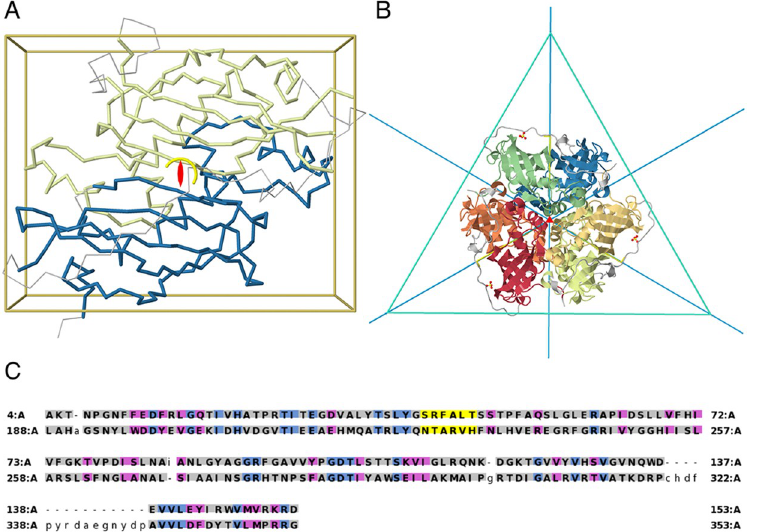
Fig 4. Hot dog fold duplication. A) Internal C2 symmetry in one chain of a MaoC domain protein dehydratase from Chloroflexus aurantiacus (4E3E) displaying a “double hot dog” fold. B) Full trimeric assembly, with the six individual hot dog domains colored. The quaternary structure has a threefold cyclic symmetry that combines with the twofold internal symmetry into a dihedral D3 symmetry equivalent to the quaternary structure of homologs without the internal domain duplication. C) Sequence alignment showing that the catalytic R/N-####-H motif (yellow) is lost in the first domain but retained in the second. Amino acid identity is shown in blue and similarity in magenta.